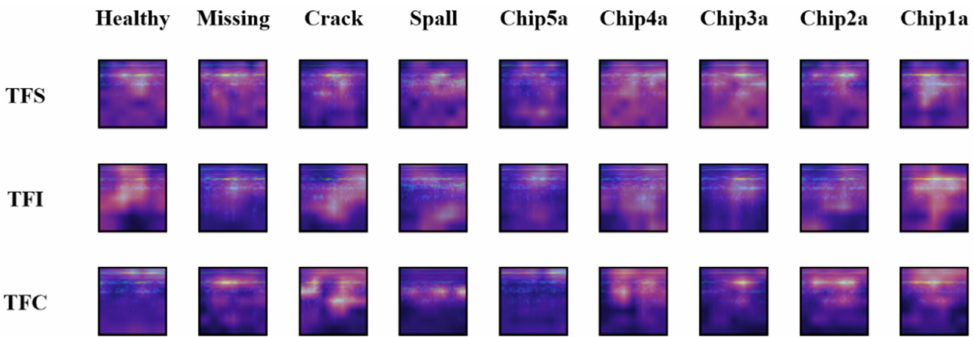
Figure 12. Heat map comparison of the three learning schemes under various working